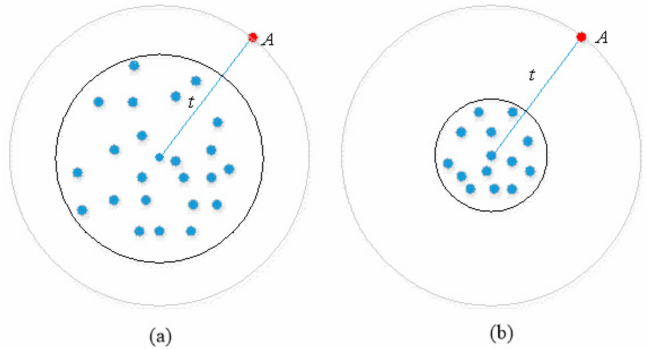
Figure 2. The di ff erence of the a ffi nity among samples at two di ff erent classes.